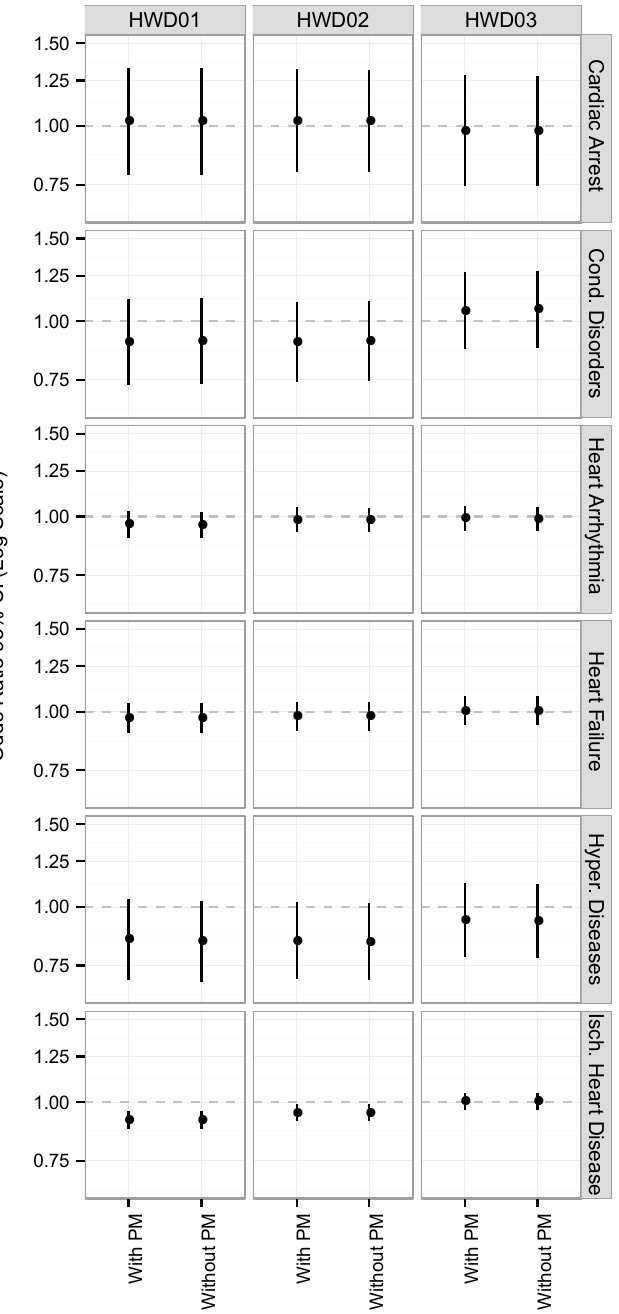
Figure 1. The association between heat wave days and “emergency” hospital admissions (EHAs) for six cardiovascular diseases with and without controlling for daily average particulate matter (PM 10 ) at lag 0 in the SSD during the warm season, 2001 to 2013. Note: Cond. Disorders is conduction disorders; Hyper. Diseases is hypertensive diseases; Isch. Heart Disease is Ischemic Heart Disease.